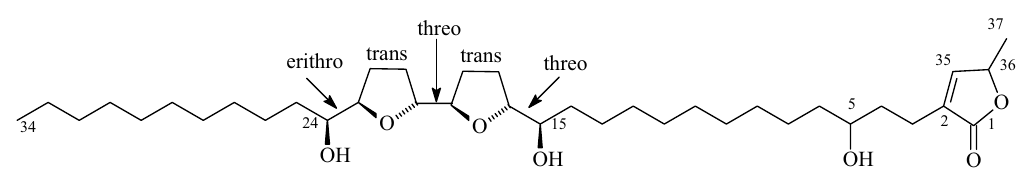
Fig. 2 – Structure of Acetogenin 1